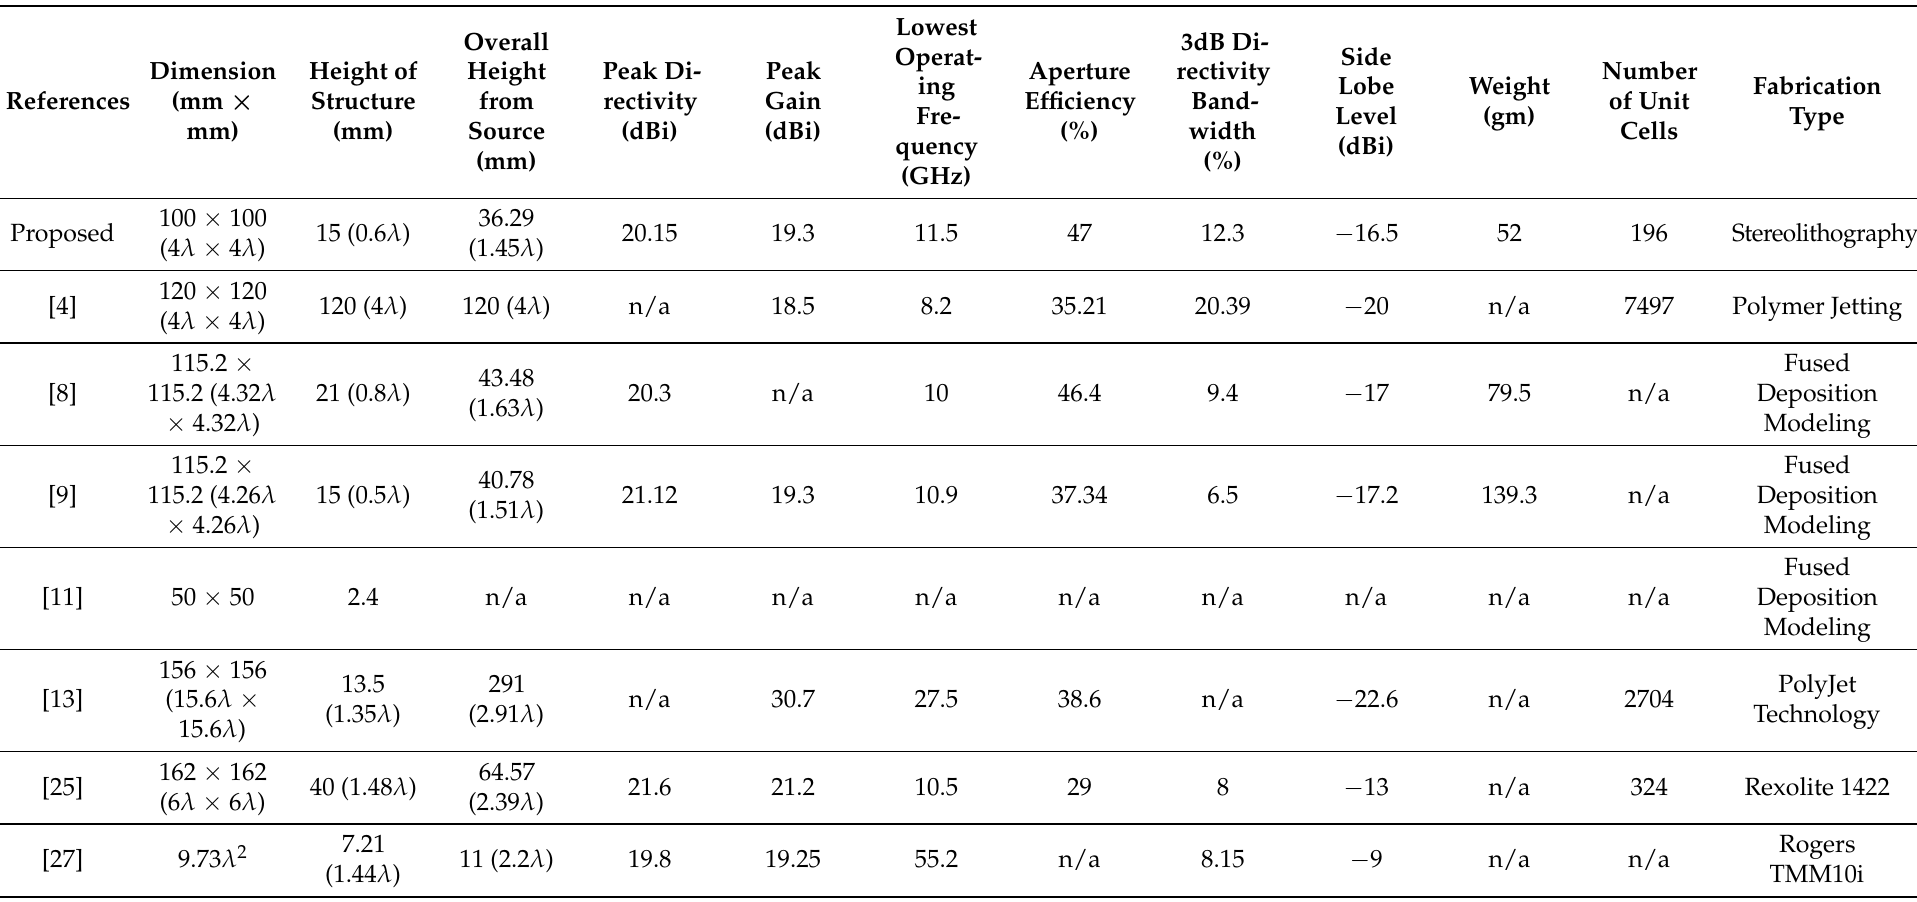
Table 1. Comparing the performance of the proposed meta-structure with relevant works in the